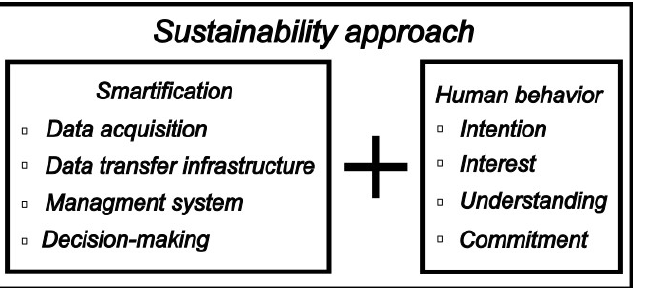
Figure 1. Smartification with a sustainability